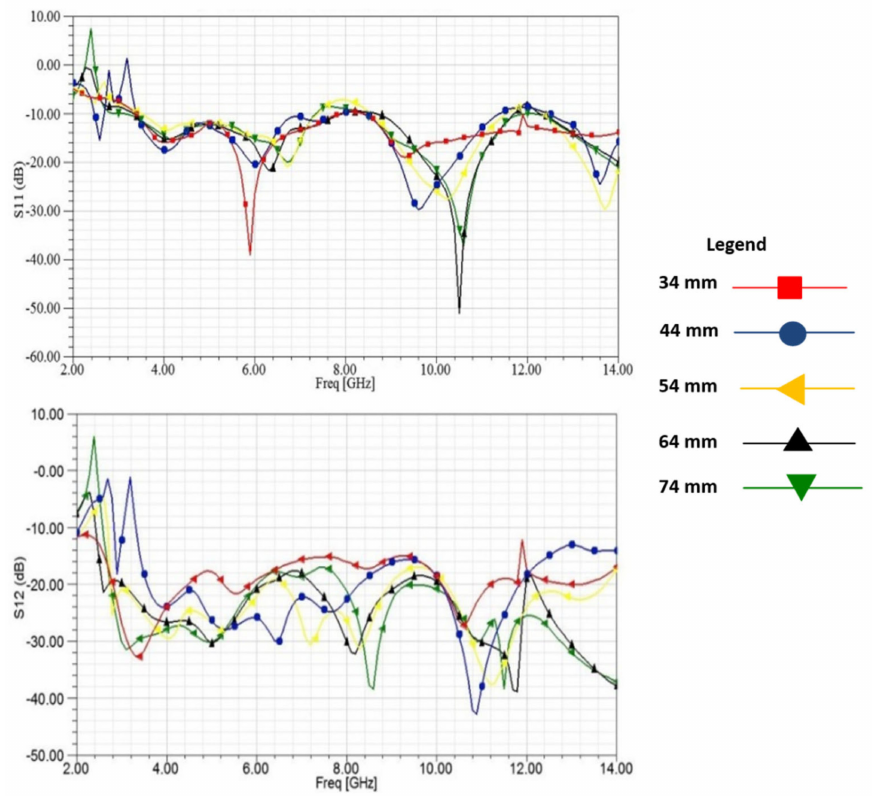
Figure 7. S–parameter of decoupling structure of the MIMO antenna with variations in d